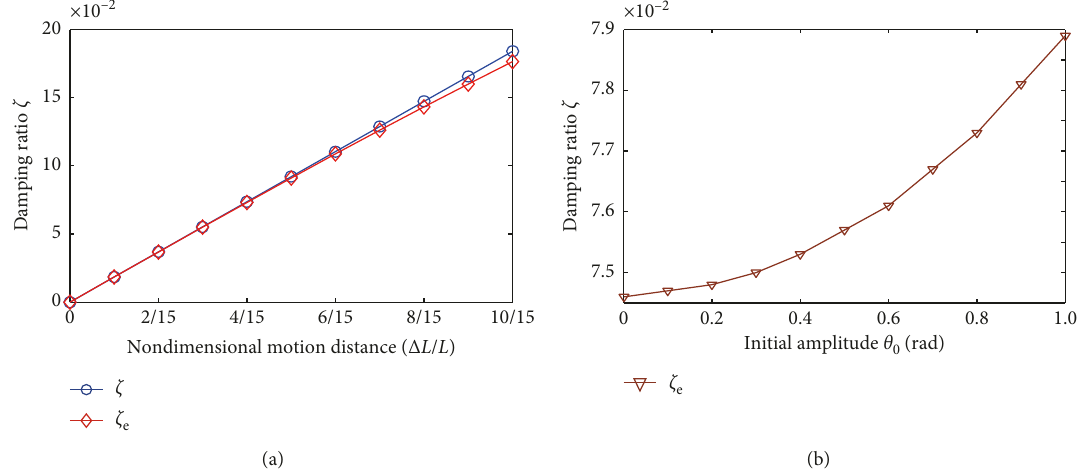
∆ L on the equivalent damping ratio ζ and the exact